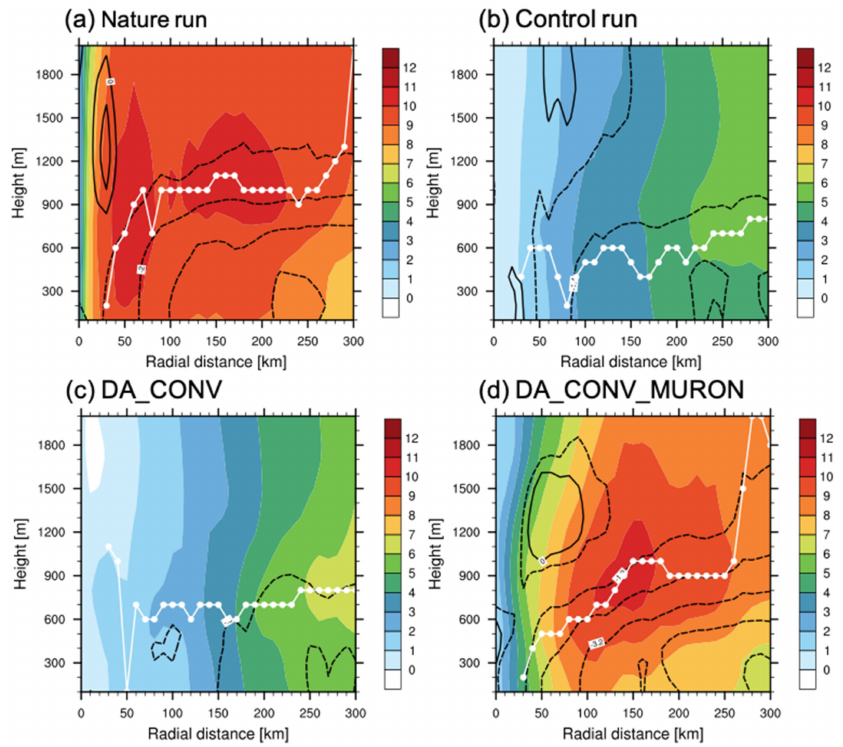
Figure 10. Radius–height plot of radial wind [m s − 1 ] (solid black lines for positive and dashed black lines for negative), tangential wind [m s − 1 ] (shaded), and the tropical cyclone boundary layer height [m] (white lines) for ( a ) the nature run, ( b ) the control run, ( c ) the DA_CONV analysis, and ( d ) DA_CONV_MURON analysis as a function of the radius from the storm center valid at 1800 UTC 3 November